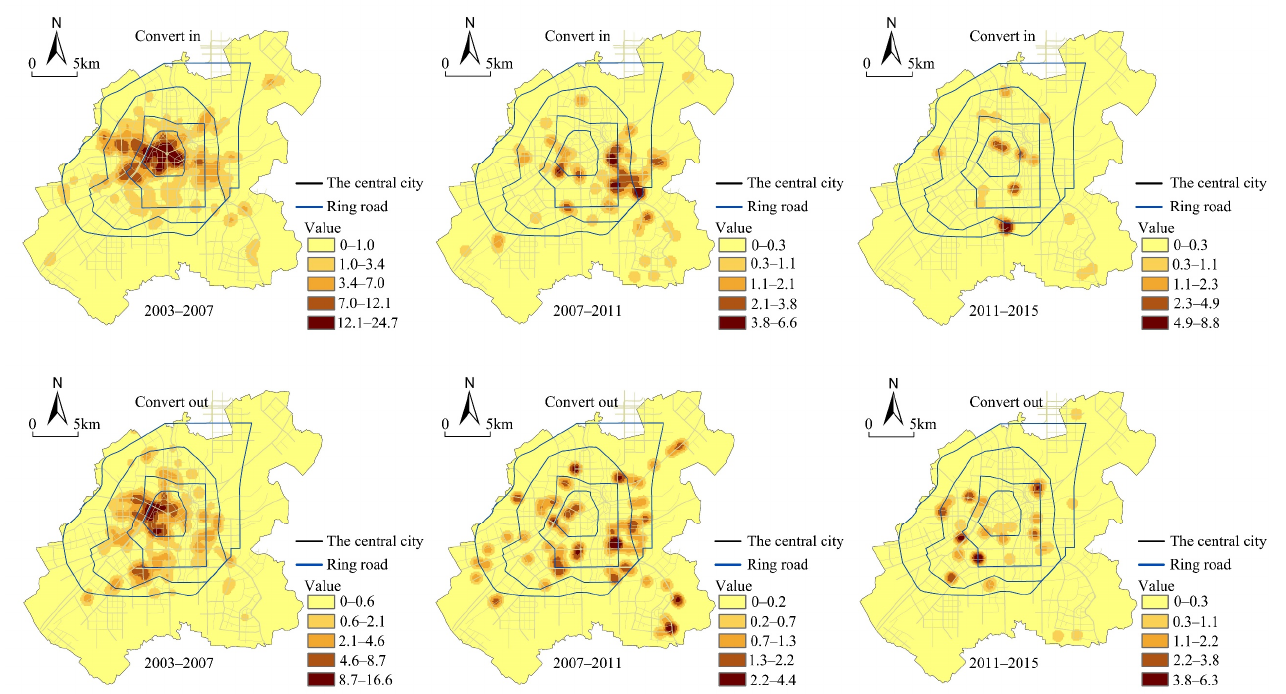
Figure 10. Kernel density map of public service land expansion in different periods.